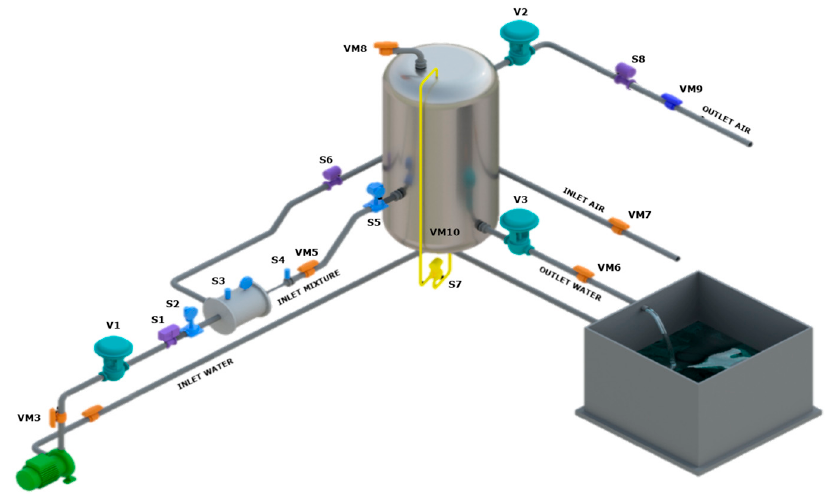
Figure 3. The experimental plant 3D model.